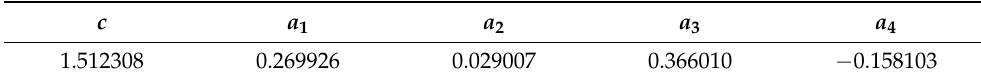
Table 1. The parameters of the mapping